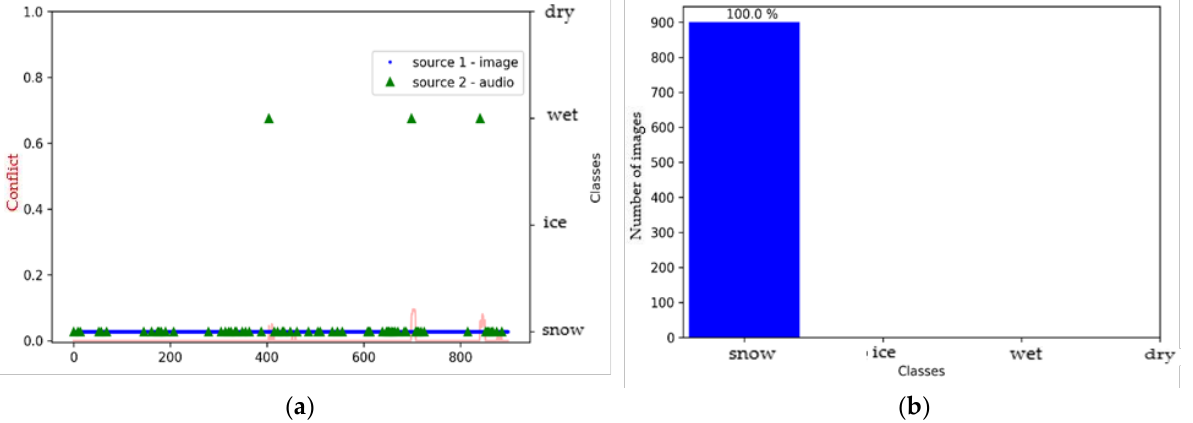
Figure 12. Environment #2. ( a ) Classification of sources with ResNet50 (video) and M5 (audio) prior to fusion, together with conflict analysis; ( b ) histogram prior to image fusion.